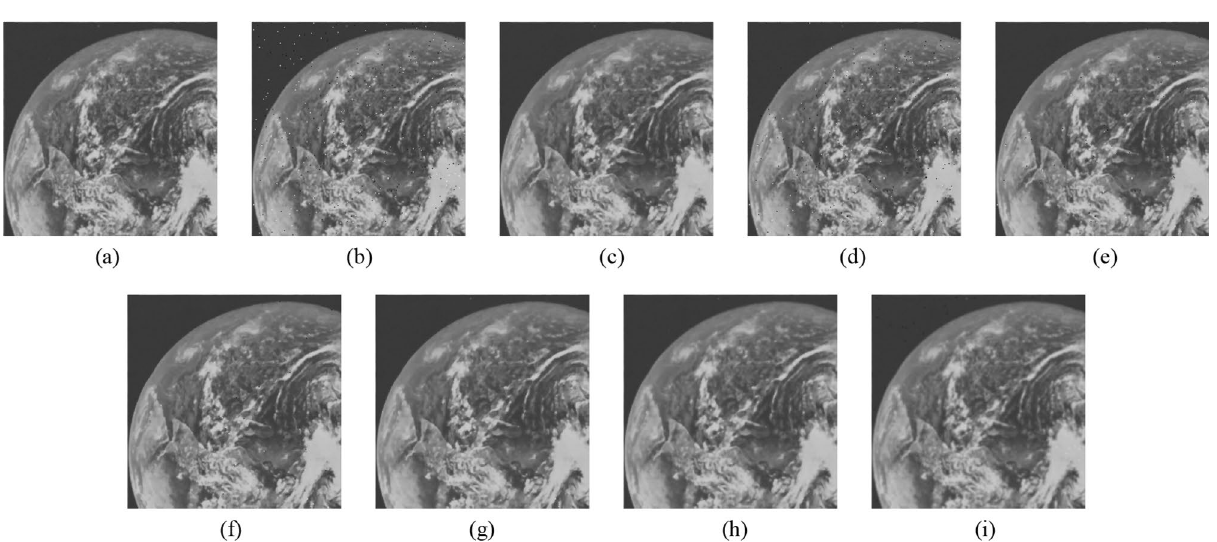
Figure 14. Comparison of denoising performance of each filter against the salt-and-pepper noise (“Balloon”). ( a ) Original image; ( b ) noise-added image; ( c ) filtered image using abwFMGFI; ( d ) filtered image using FMGFI (BW = 1 level); ( e ) filtered image using FMGFI (BW = 3 level); ( f ) filtered image using FMGFI (BW = 5 level); ( g ) filtered image using FMGFI (BW = 11 level); ( h ) filtered image using FMGFI (BW = 21 level); ( i ) filtered image using FMGFI (BW = 51 level).